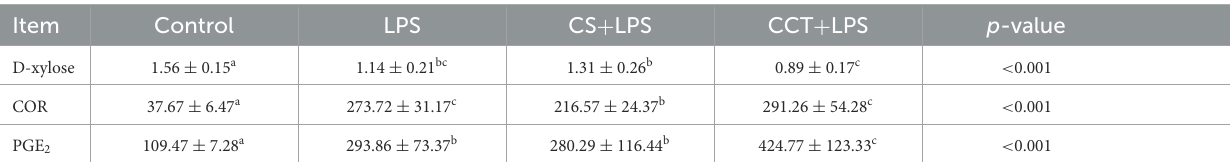
TABLE 5 CCT and CS supplementation on the concentrations of D-xylose, COR (Cortisol), and PGE 2 (Prostaglandin E2) in the plasma of LPS-challenged piglets.